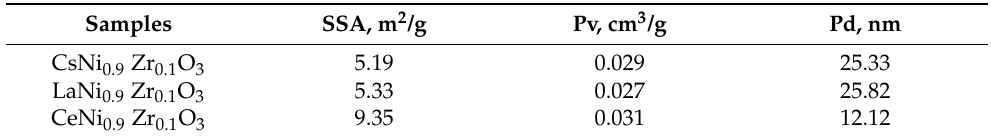
Table 1. Specific surface area (SSA), Pore volume (Pv), and Pore diameter (Pd) of the fresh cata- lyst samples.